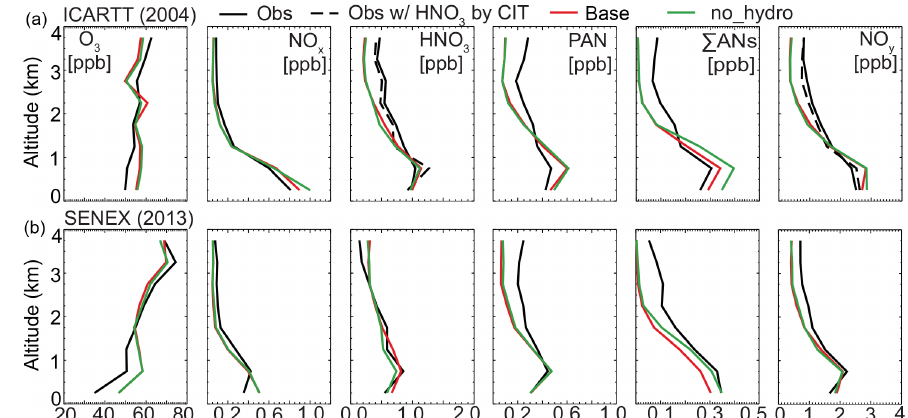
Figure 1. Mean vertical profiles of ozone and reactive oxidized nitrogen from observations during ICARTT (a) and SENEX (b) over the Southeast US (25–40 ◦ N, 100–75 ◦ W) during daytime and model estimates from AM3 with hydrolysis of ISOPNB (red) and AM3 without hydrolysis of alkyl nitrates (green). The solid and dashed black lines in the HNO 3 of ICARTT represent measurements collected using mist chamber–ion chromatograph by the University of New Hampshire (UNH) and chemical ionization mass spectrometry by the California Institute of Technology (CIT), respectively. NO y from ICARTT is calculated as the sum of NO x , HNO 3 (UNH in the solid line and CIT in the dashed line), PAN, and total alkyl nitrates ( (cid:54) ANs). Observed and modeled (cid:54) ANs in (b) are during SEAC 4 RS.